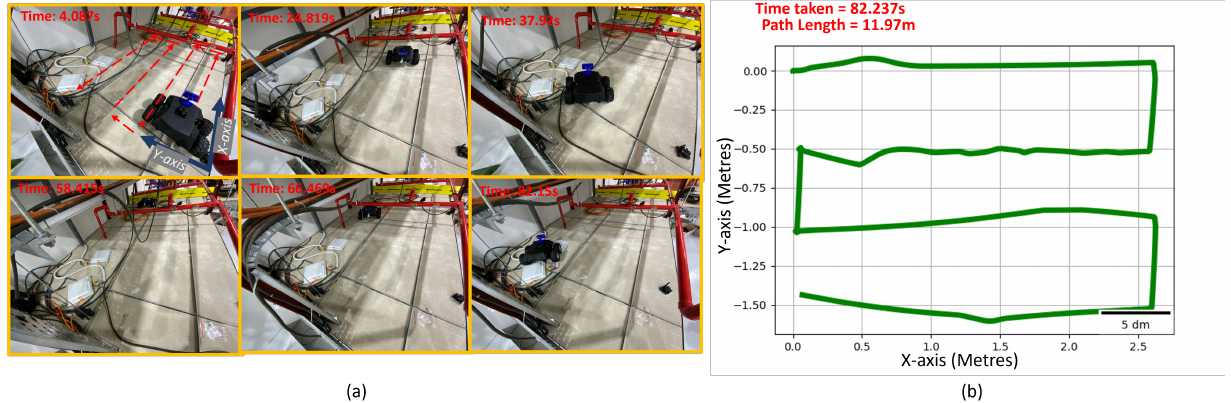
Figure 16. The experiment trial performed in the false-ceiling test-bed for covering 3 × 2 m. ( a ) Robot performing inspection in the false-ceiling test-bed at various time frames. ( b ) Fused odometry plot of robot during experimental trial.